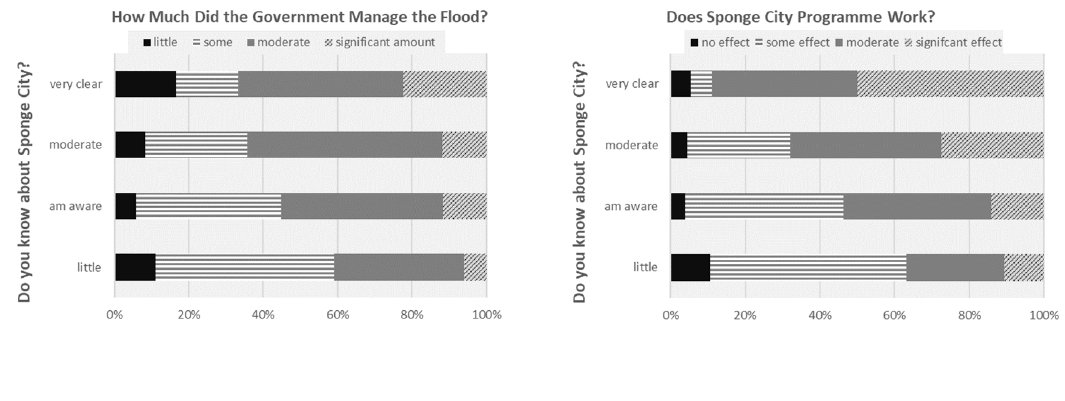
Figure 7. The knowledge of Sponge City (Q8) about ( A ) the perception of the degree of flood management conducted by the government (Q7); ( B ) the perception of whether the program works (Q9).